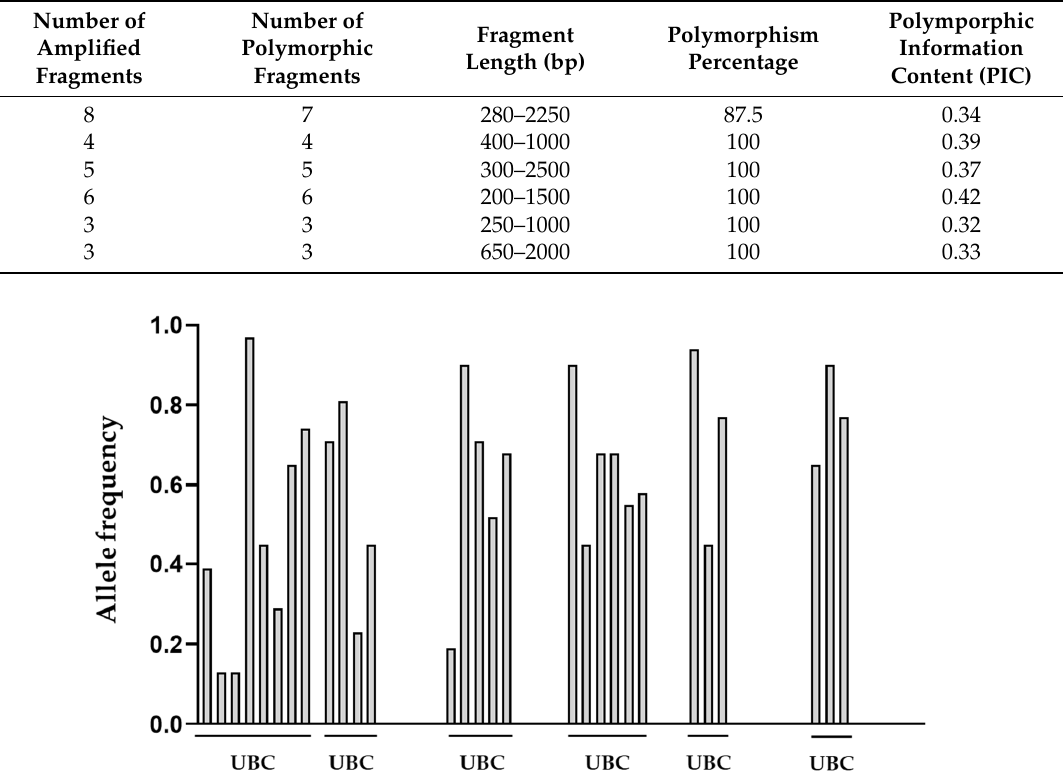
Table 4. Number of amplified fragments, number of polymorphic bands and polymorphism percent- age of each primer used in ISSR analysis.